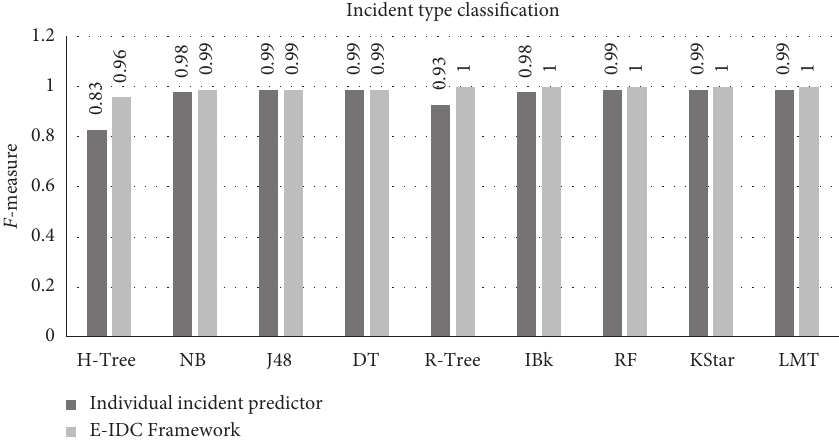
Figure 8: F-measures of individual and ensemble E-IDC predictors.